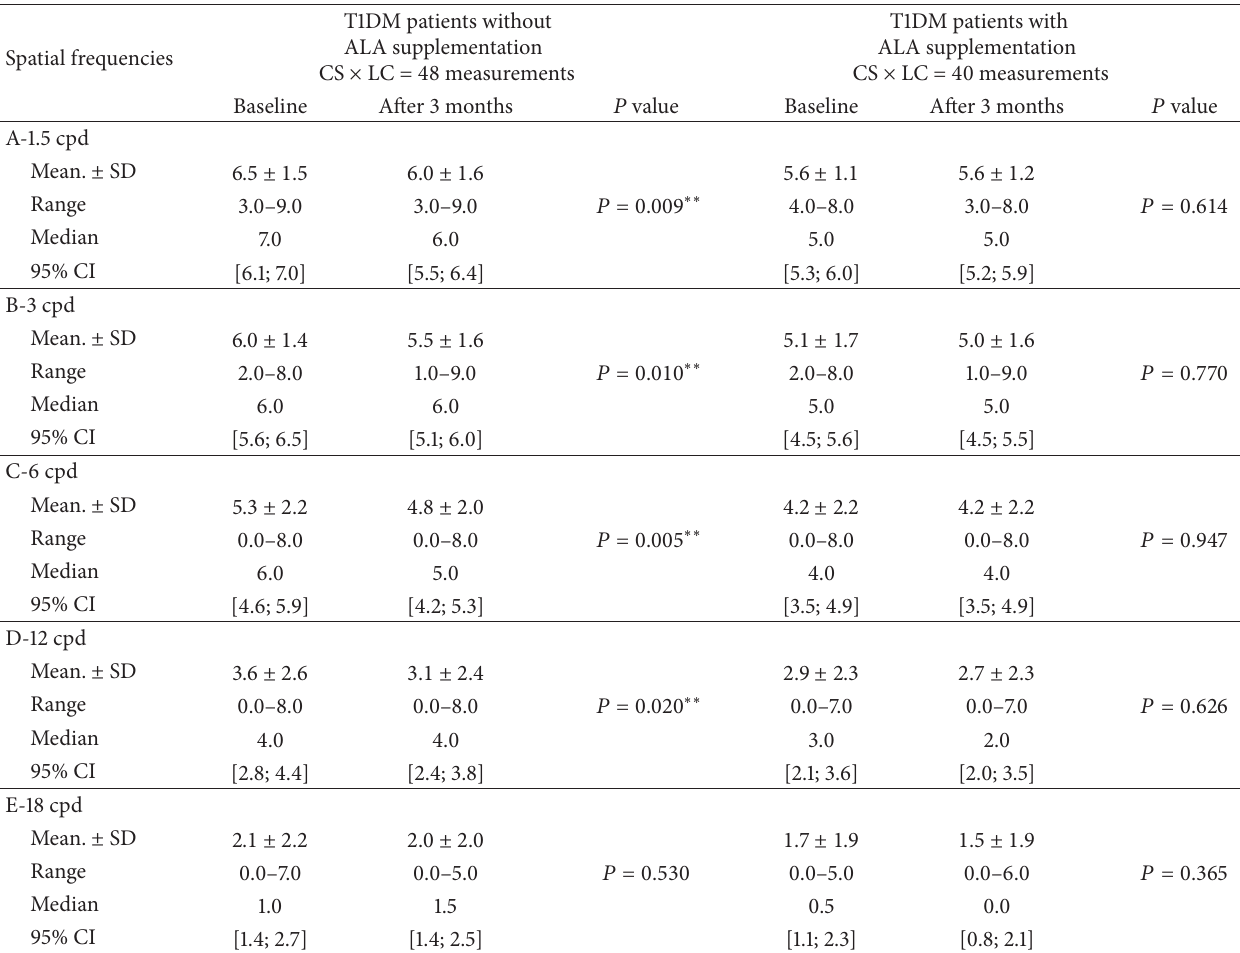
Table 2: Characteristics of contrast sensitivity examinations in T1DM patients with and without ALA supplementation at baseline and after 3